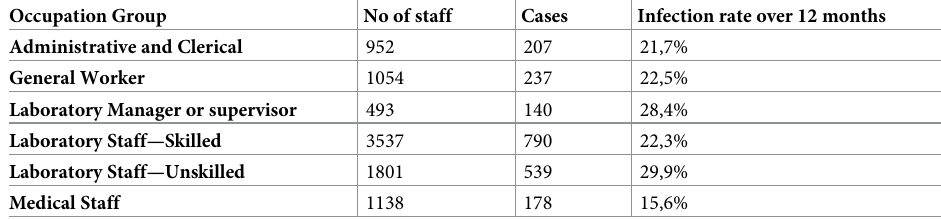
Table 2. Infection rate of COVID-19 reported in OHASIS for medical laboratory staff, by occupation group over 12